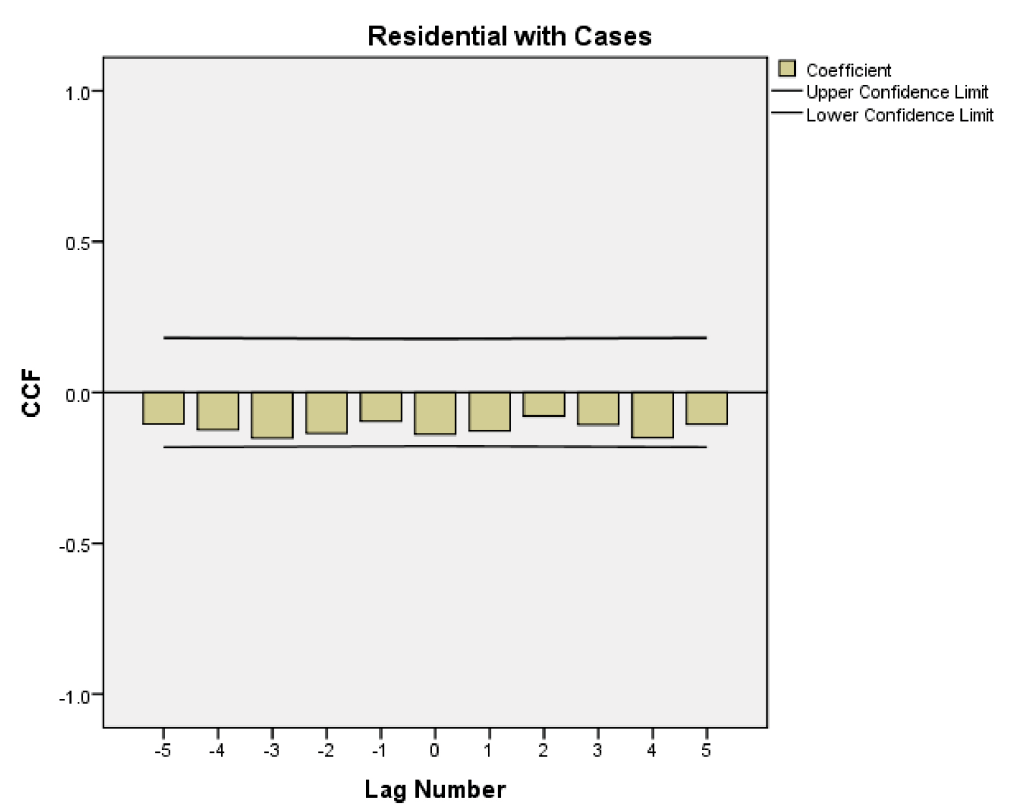
Figure 4: Cross Correlation Coefficients for Residential Areas and Cases